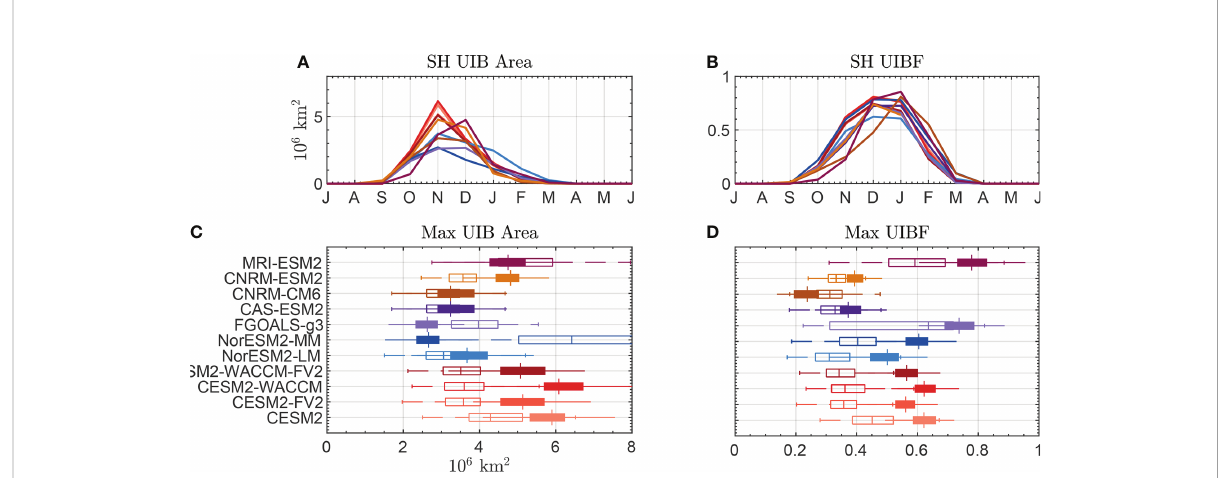
FIGURE 4 Statistics of bloom-permitting area for CMIP6 models. (A) Seasonal cycle of the UIB-permitting area in the Southern Hemisphere. (B) Seasonal cycle of UIBF. (C) Box plots of the maximum annual UIB area in ( fi lled) the Southern Hemisphere or (un fi lled) the Northern Hemisphere. (D) Box plots of UIBF during the month of maximum UIB area. Colors of lines in (A, B) correspond to boxes in (C, D)